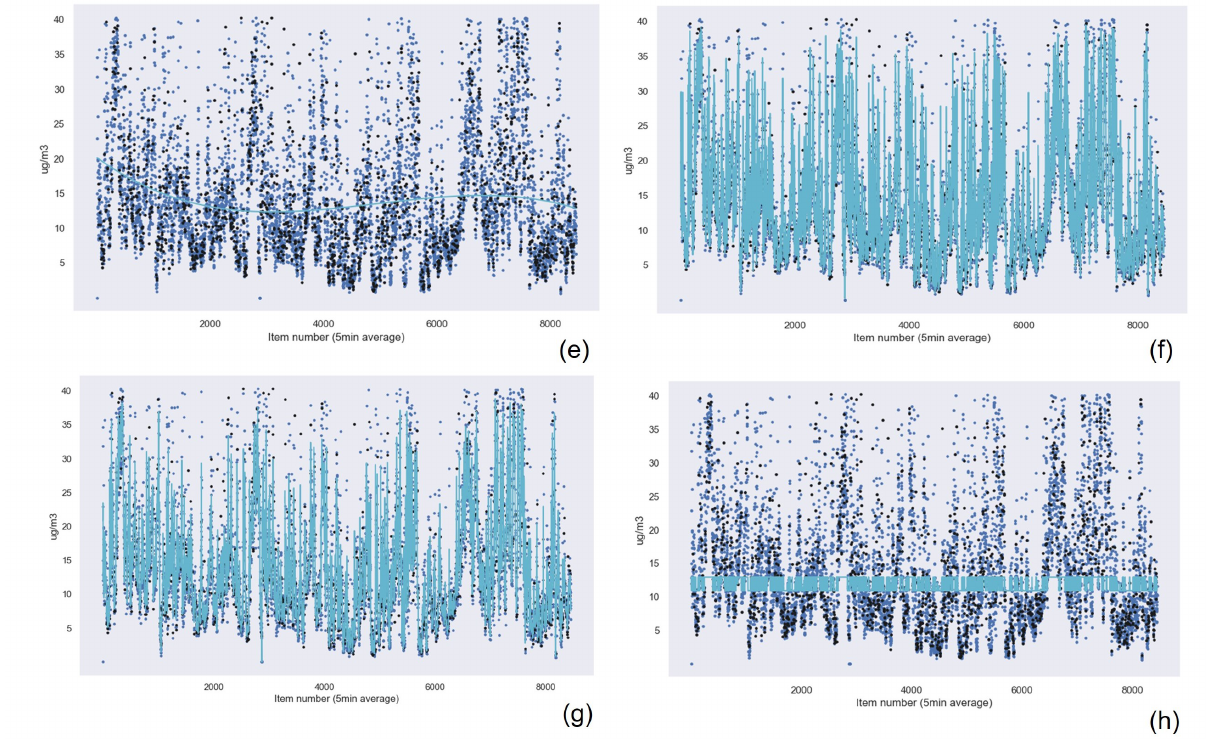
Figure A17. PM 10 results of the articulate matter measuring device # 2 with outliers for ( a ) Linear Re- gression ( b ) Random Forest Regression ( c ) KNN and ( d ) Support Vector Machine, and without outliers for ( e ) Linear Regression ( f ) Random Forest Regression ( g ) KNN and ( h ) Support Vector Machine.